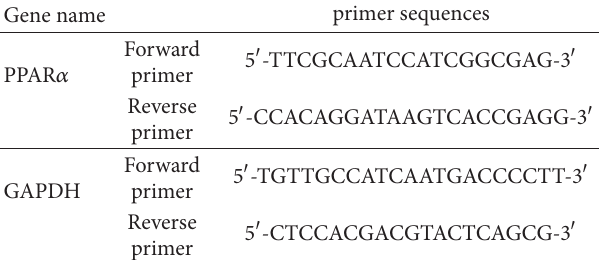
Table 1: Primers used in the real-time RT-PCR amplification of the human PPAR- 𝛼 gene and GAPDH